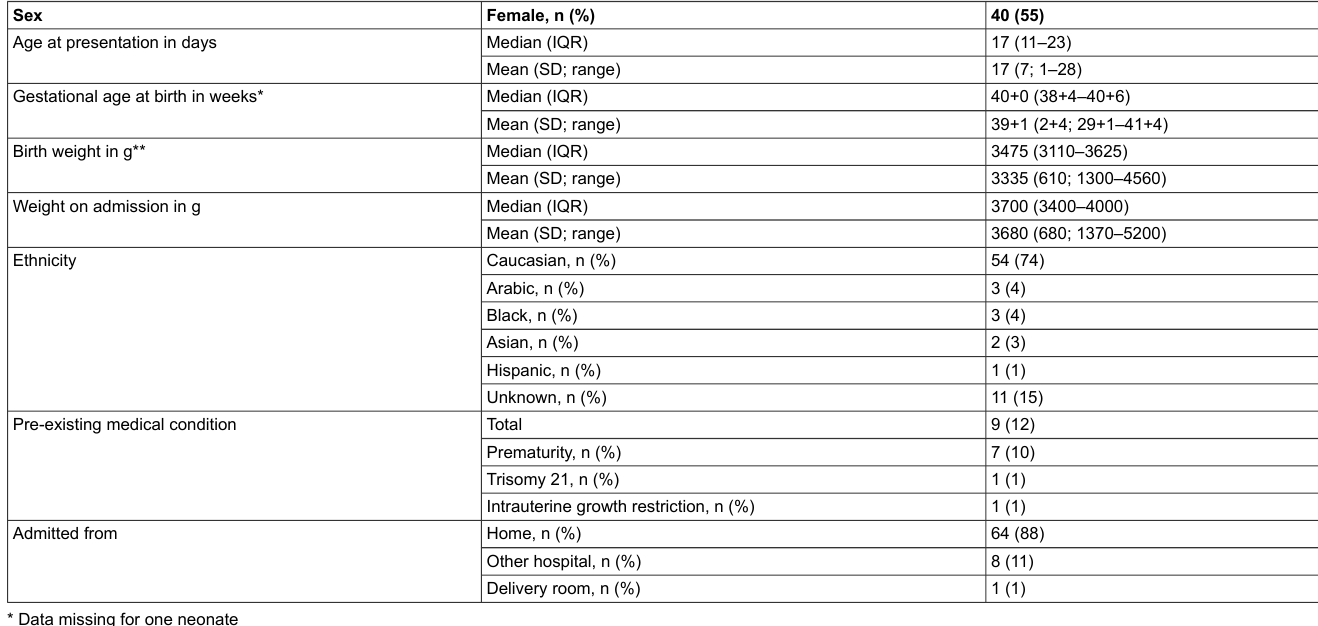
Table 1: Baseline characteristics of neonates with SARS-CoV-2 infection (n = 73). Sex Age at presentation in